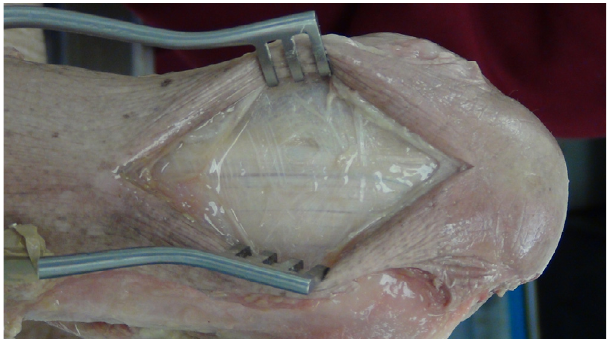
Figure 3. Fenestration of the olecranon fossa.